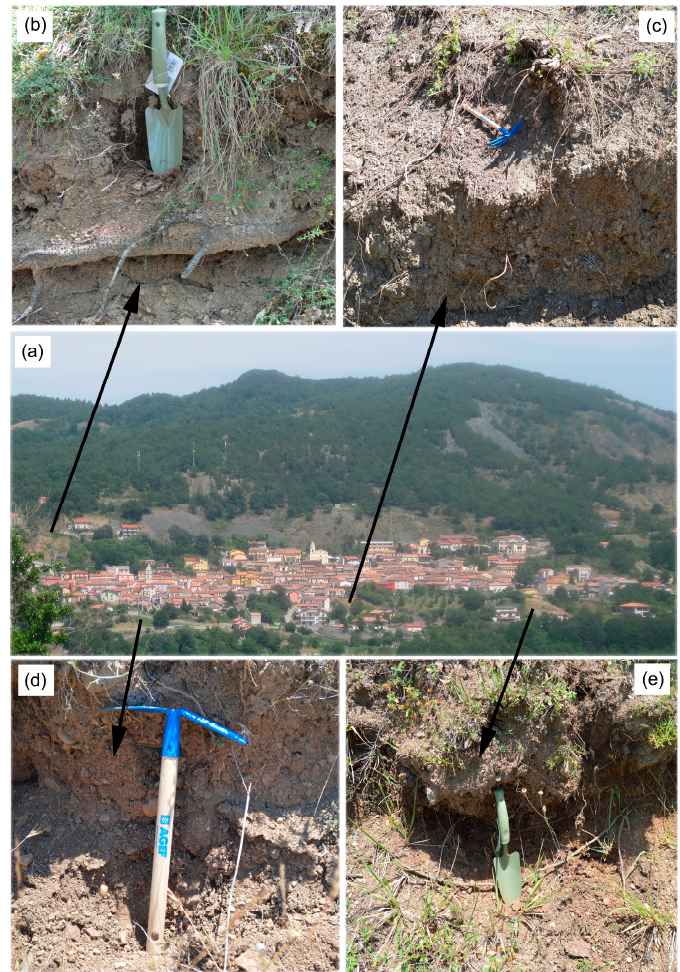
Figure 2. ( a ) Distant view of the San Severino Village (modified after [26]); ( b ) soil outcrop that contain NOA (Spol8); ( c ) soil outcrop (Spol1); ( d ) soil outcrop (Spol10); ( e ) soil outcrop (Spol2).